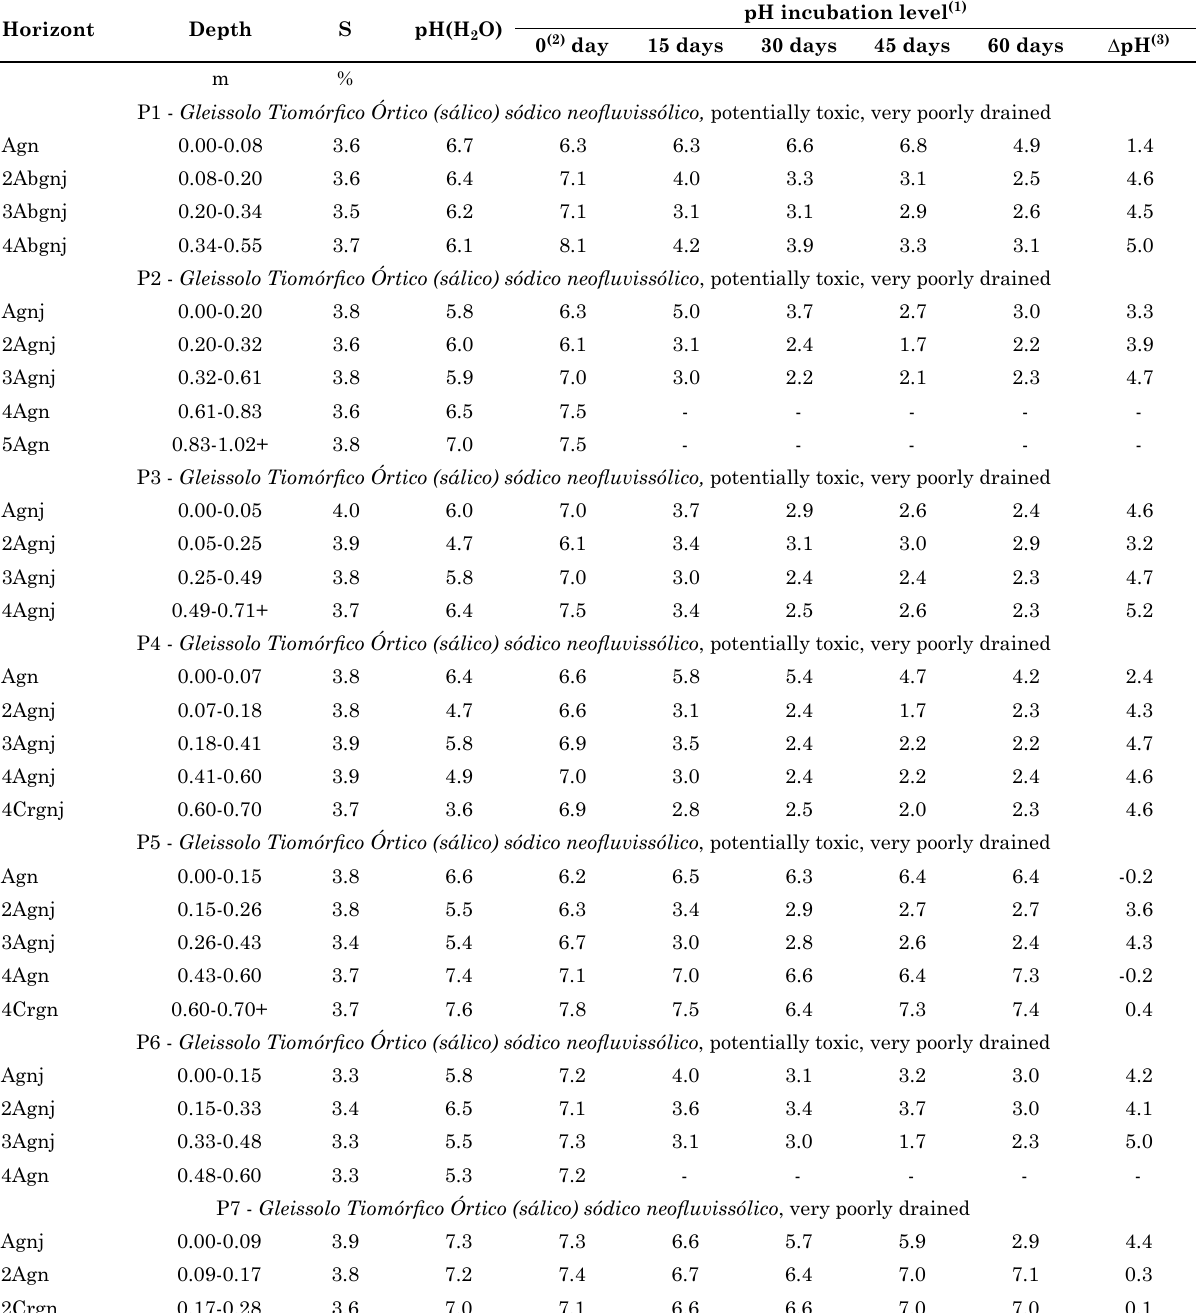
Table 2. Values for sulfur (S), pH(H 2 o) , and pH incubation of mangrove soils in the Subaé river basin, Santo Amaro, Bahia, Brazil